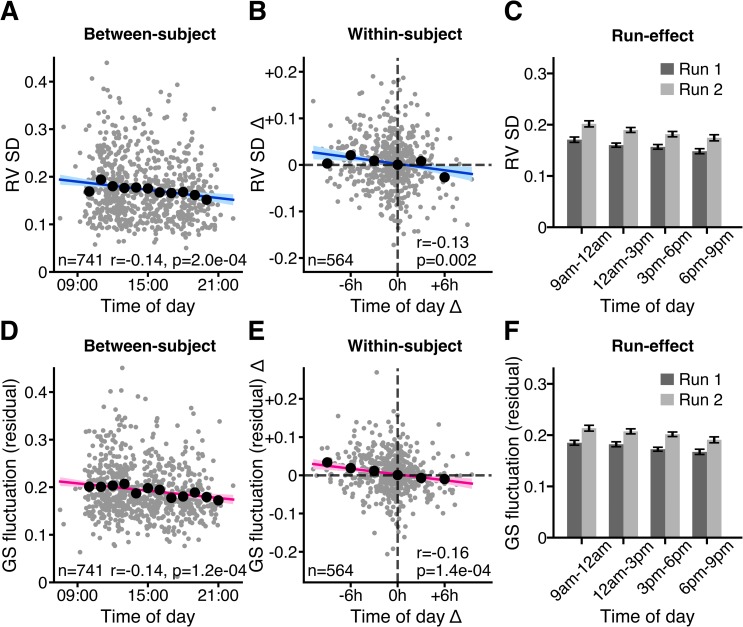
Negative association between time of day and GS fluctuation remains significant after controlling for respiratory variation.(A) Between-participant variation, (B) within- participant variation, and (C) run effects of RV SD as a function of time of day. (D) Between-participant variation, (E) within-participant variation, and (F) run effects of GS fluctuation residual (after regressing RV SD) as a function of time of day. Same as in Fig 1, within-participant effects were computed by taking the difference (Δ) for each variable between session 2 and session 1. Grey dots denote individual participants. Confidence interval is shown in light blue or in light pink. Black dots denote mean of GS fluctuation in hourly (A, D) or 3-hourly (B, E) time windows. R values denote Pearson correlation coefficients. p-Values were derived from 100,000 permutations while keeping family structure intact [40]. This figure shows the results for session 1 (see S3 Fig for session 2). See S1 Data for underlying data. GS, global signal; RV SD, standard deviation of respiratory variation.